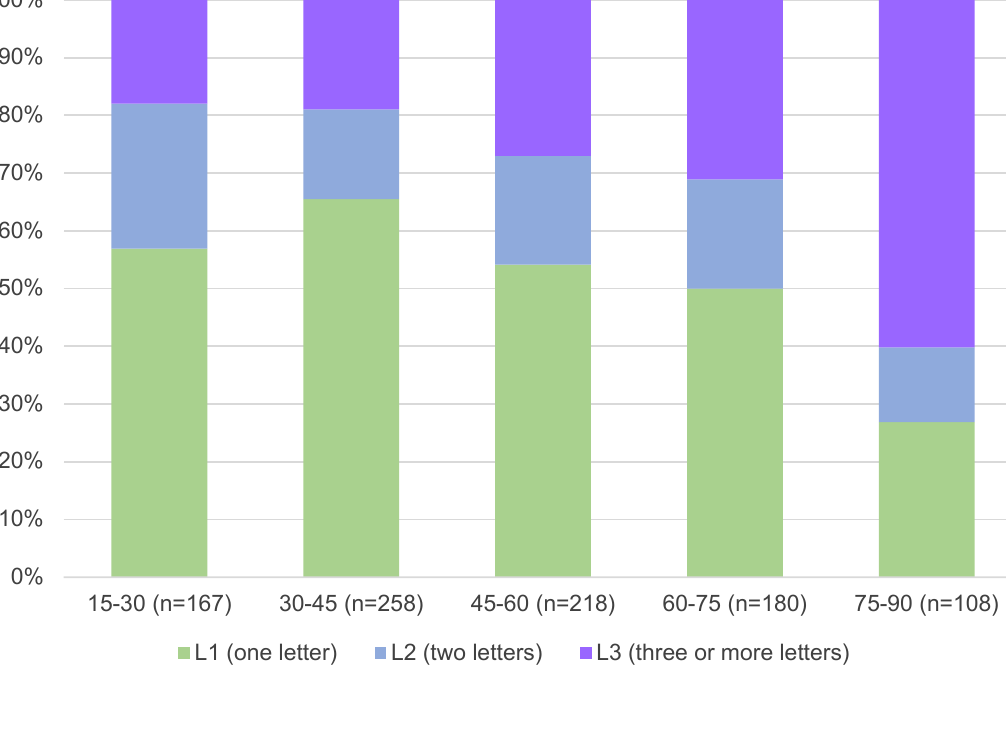
Figure 15: Distribution of fingerspelling-related tokens by nativisation category (L only) and age